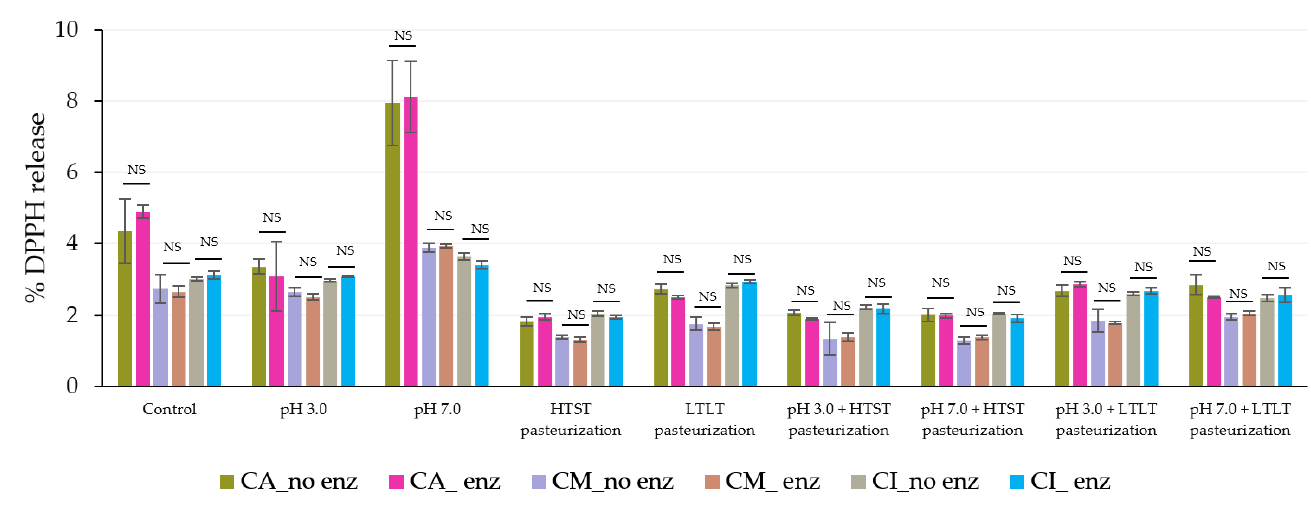
Figure 9. % DPPH release during simulated gastrointestinal conditions in the gastric phase (120 min) with and without pepsin. NS indicated no significant differences at p ≤ 0.05. The error bars indicate the SD of the data. The control sample was microbeads after air-drying.